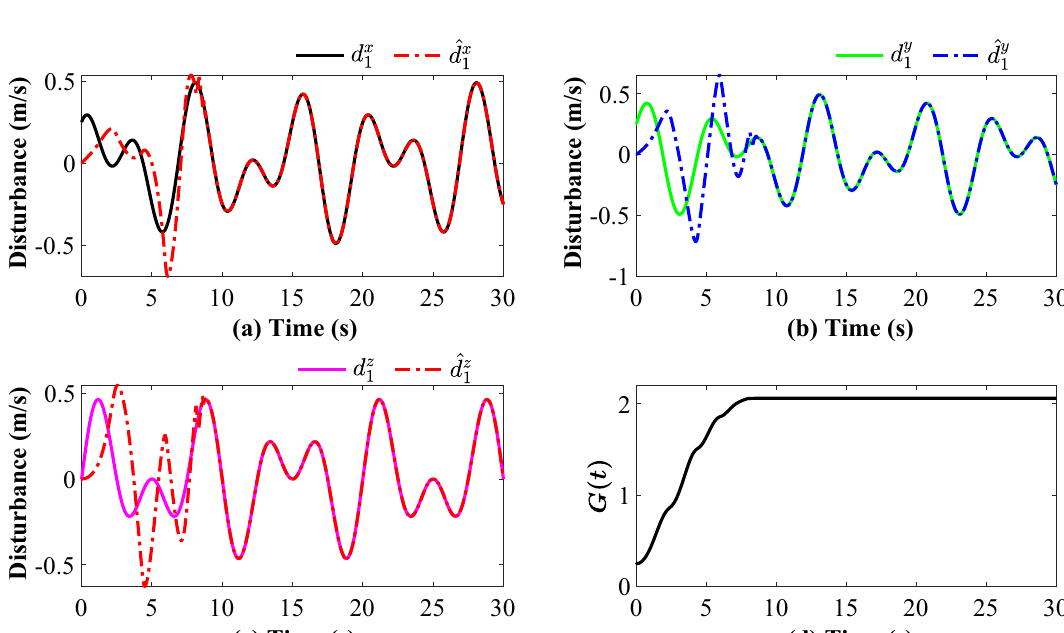
Figure 5. Simulation result: ( a ), ( b ), ( c ) and ( d ) represent X, Y, Z disturbance tracking and G ( t ) in follower 1,